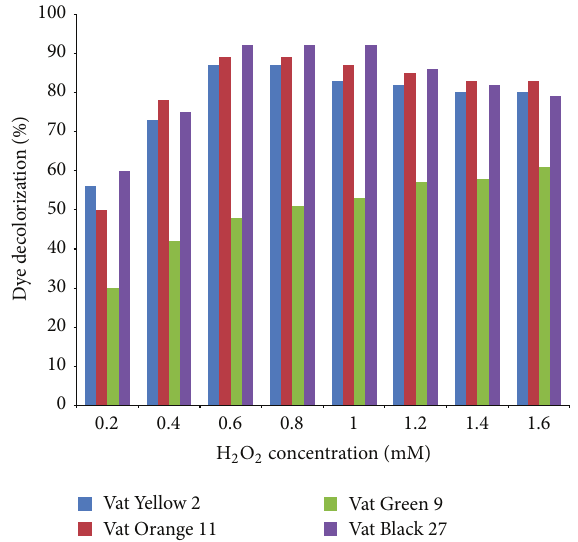
Figure 11: Effect of different concentrations of H 2 O 2 on dye decolourization with garlic peroxidase.